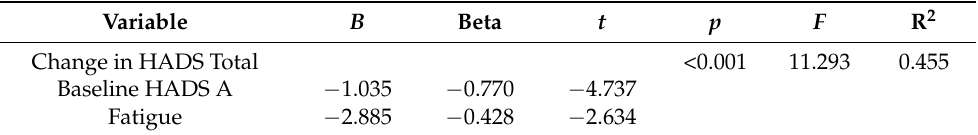
Table 5. Baseline functional capacity, quality of life, depression and anxiety as predictors of change in HADS Total.